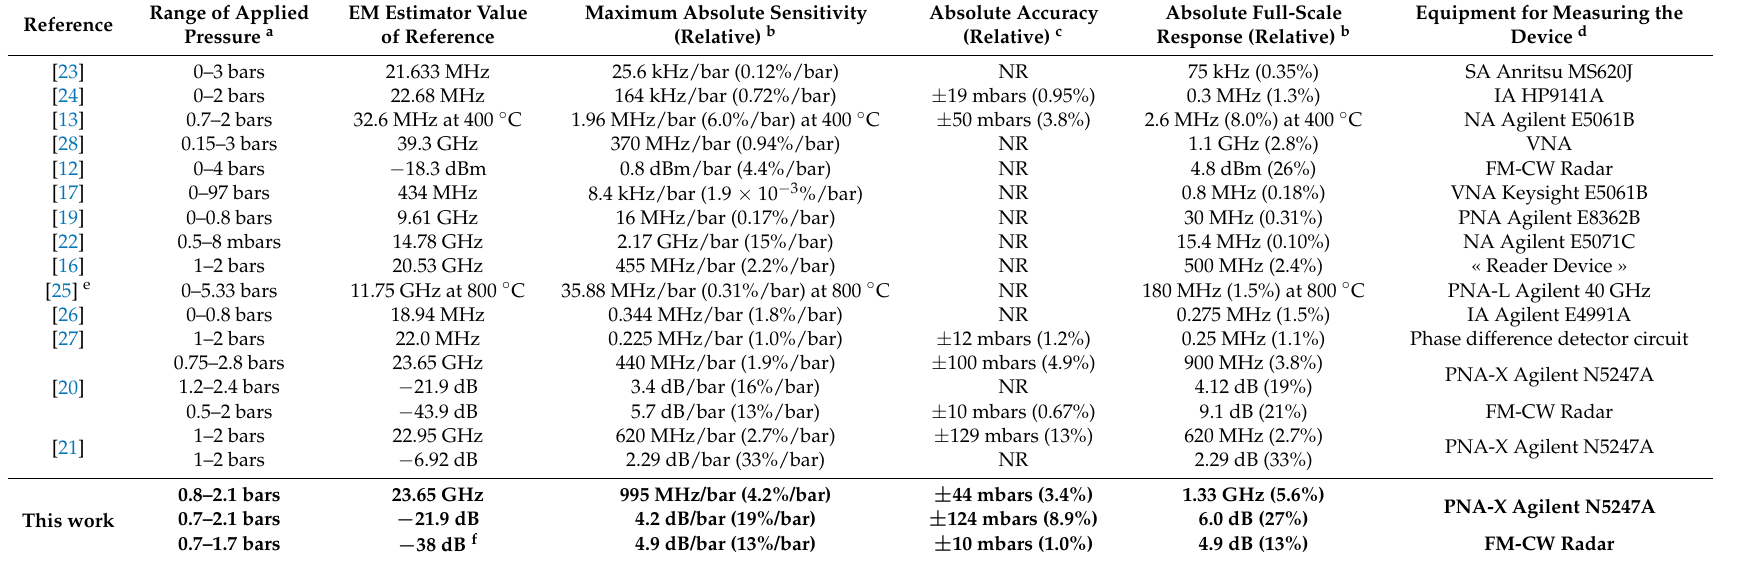
Table 1. Characteristics of published wireless and passive pressure sensors—sensing